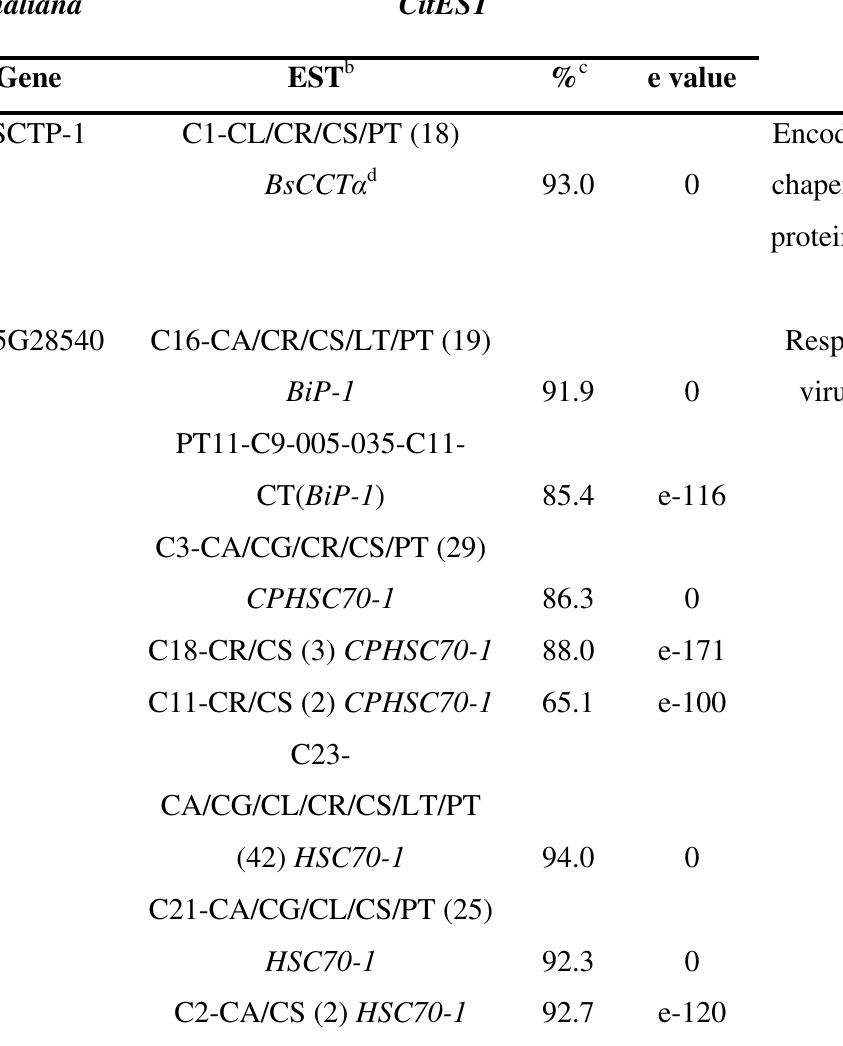
Table S4 –Citrus ESTs with homology to the heat shock proteins (HSP) gene family from Arabidopsis thaliana and other model species. Arabidopsis